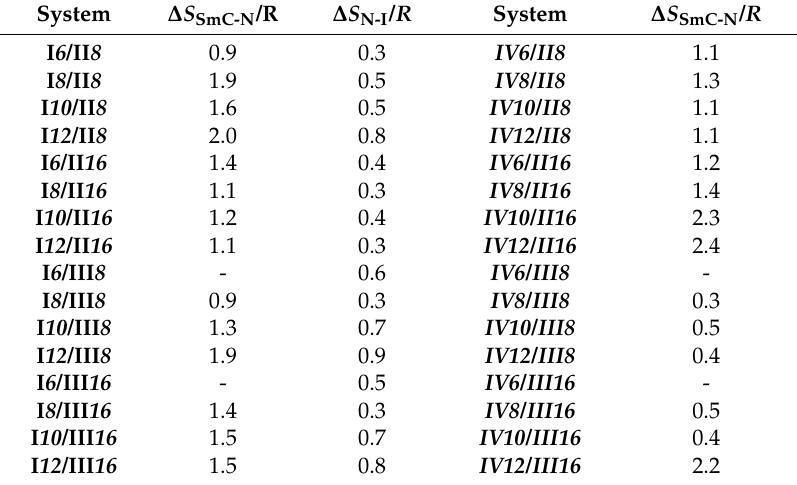
Table 6. Transition entropies ( ∆ S / R ), for the supramolecular complexes I n / II m , I n / III m , IV n /II m and IV n /III m .